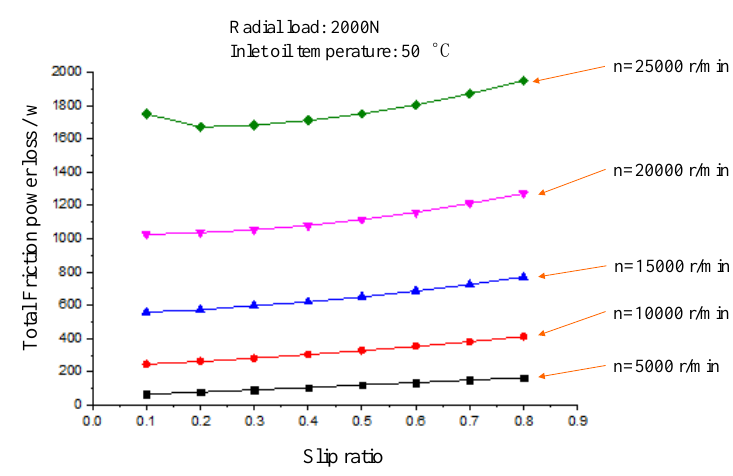
Figure 5. Effect of the inner ring speed on the total friction power loss of the bearing.